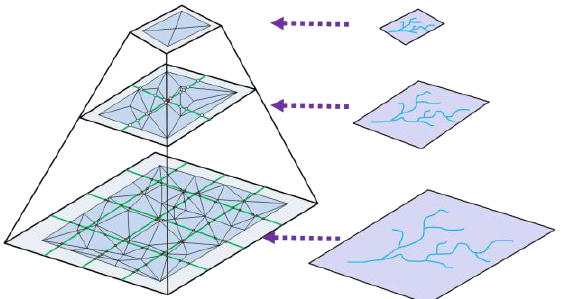
Figure 1. The process of multi-resolution TIN pyramid construction.